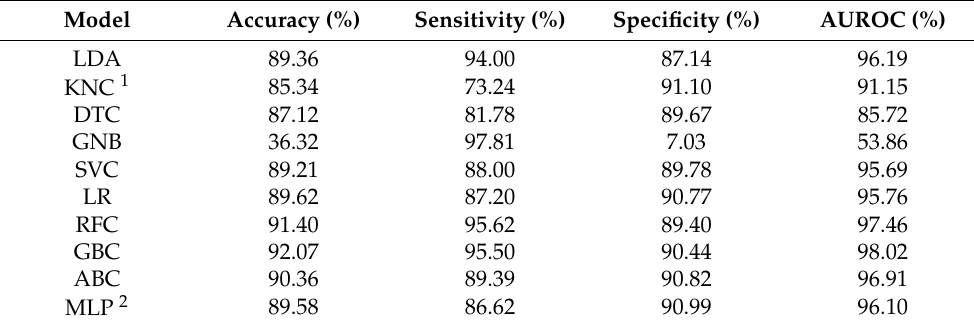
Table 3. Performance of ML models in the prediction of receiving PCI treatments. Model